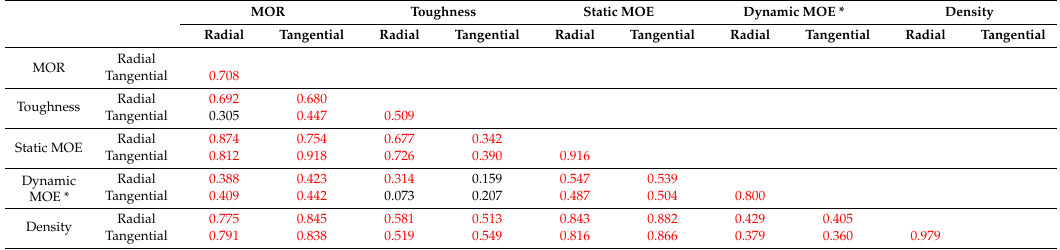
Table A9. Values of Correlation Coe ffi cients Between Given Quantities for Oak Wood.